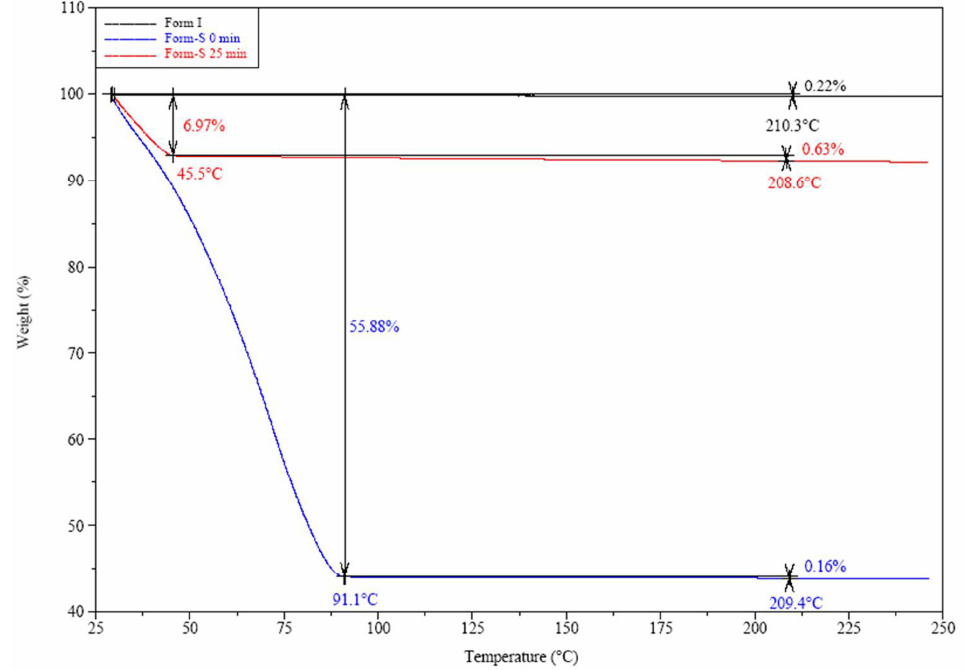
Figure 10. TGA thermograms of posaconazole Form I and posaconazole Form-S immediately after its isolation (0 min) and 25 min after its isolation. its isolation (0 min) and 25 min after its